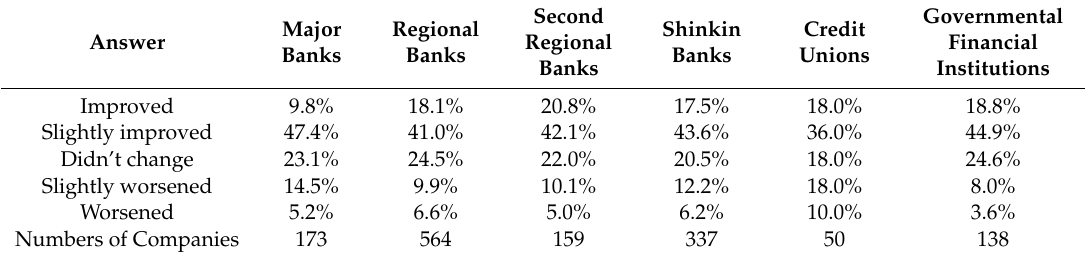
Table 9. Business performance separated by the type of company’s main